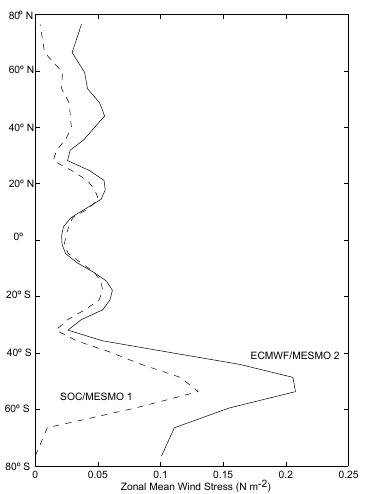
Fig. 1. Zonal mean of surface wind stress fields SOC (Josey et al., 2002) used in MESMO 1 and ECMWF (Trenberth et al., 1989) used in MESMO